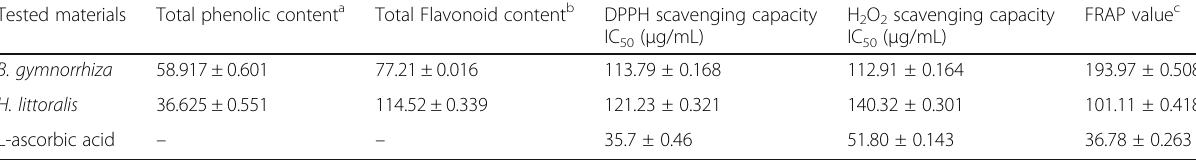
Table 1 Antioxidant properties of methanol leaf extract of selected mangrove plant species Tested